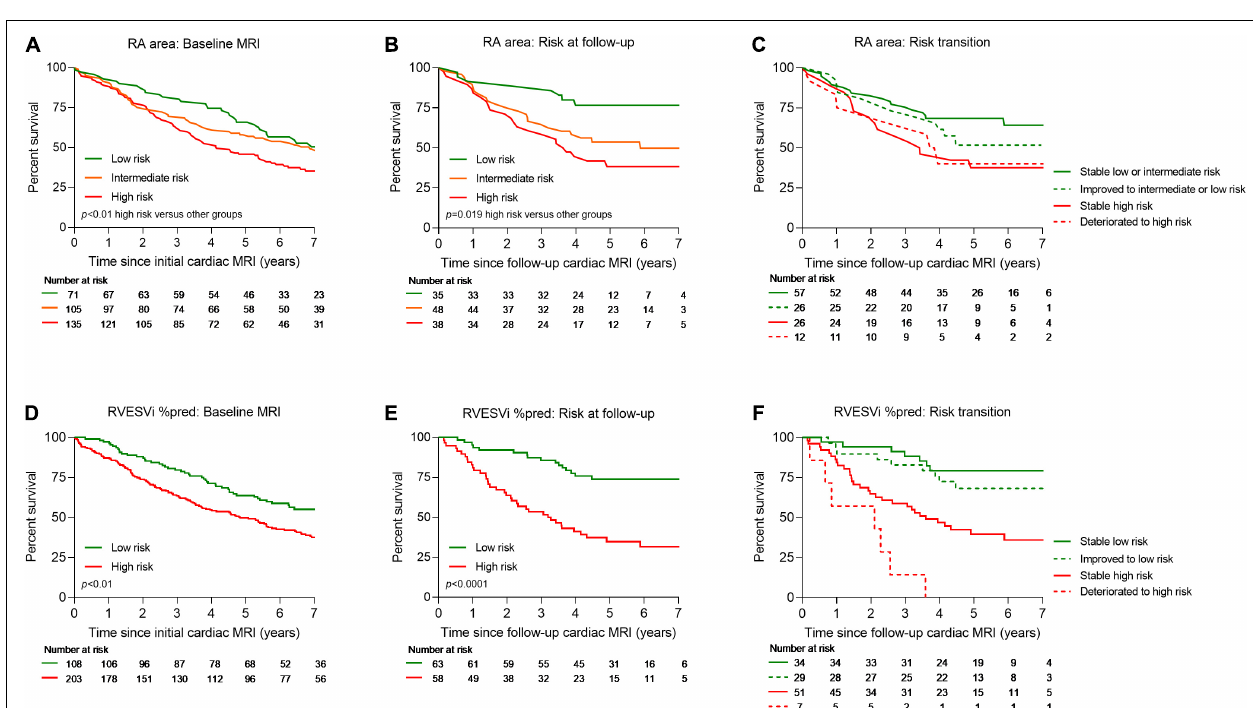
FIGURE 1 | Bar charts displaying cardiac MRI RA area thresholds based on ESC/ERS guidelines and RV metrics based on published thresholds, and percentage mortality at 1-year for treatment naïve patients at (top) baseline ( n = 311) and (bottom) follow-up ( n = 121). MRI, magnetic resonance imaging; RA, right atrial; ESC/ERS, European Society of Cardiology and European Respiratory Society; RV, right ventricular; %pred, percentage predicted for age and sex; RVESVi, right ventricular end-systolic volume index; RVEF, right ventricular ejection fraction.